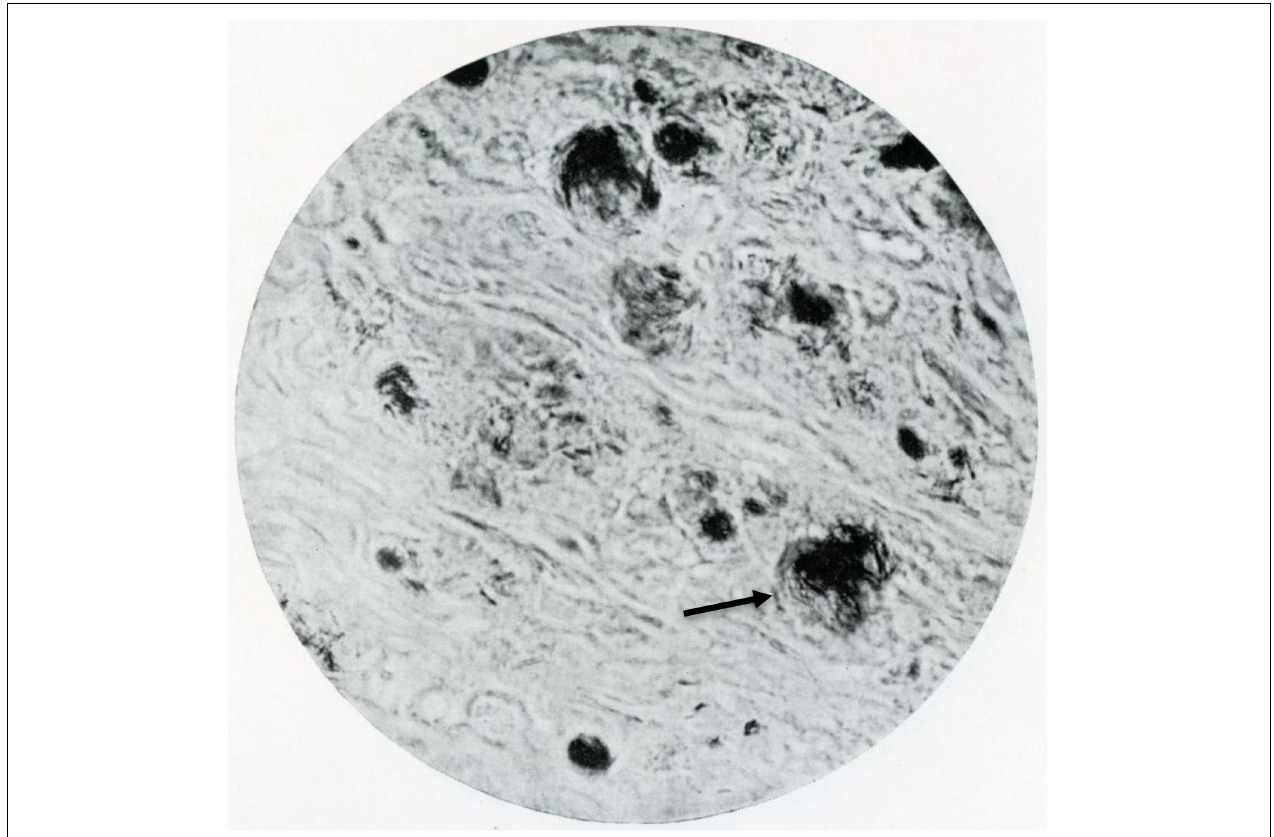
FIGURE 3 | Vacuoles with AFB in globi and granular forms; see